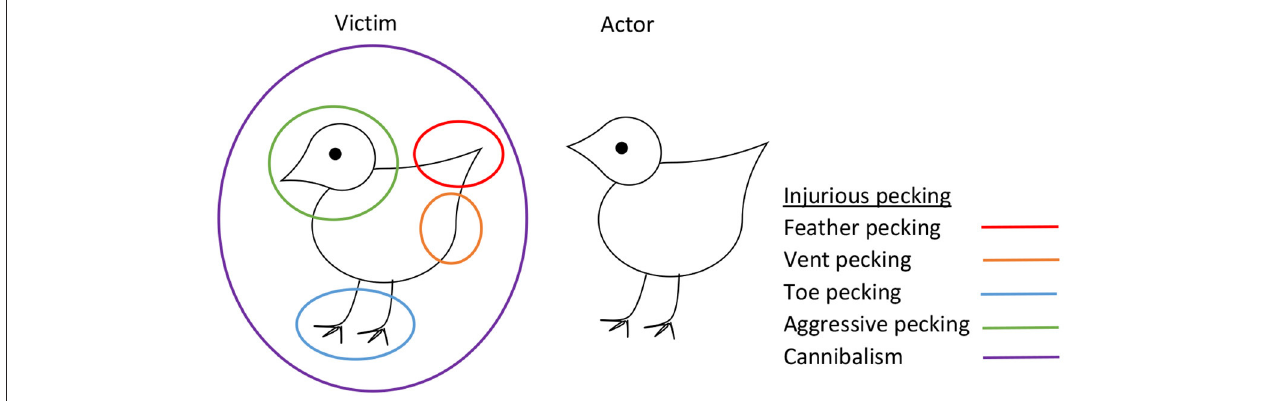
FIGURE 1 | Injurious pecking in laying hens, showing different types of pecking in relation to target areas on the victim.